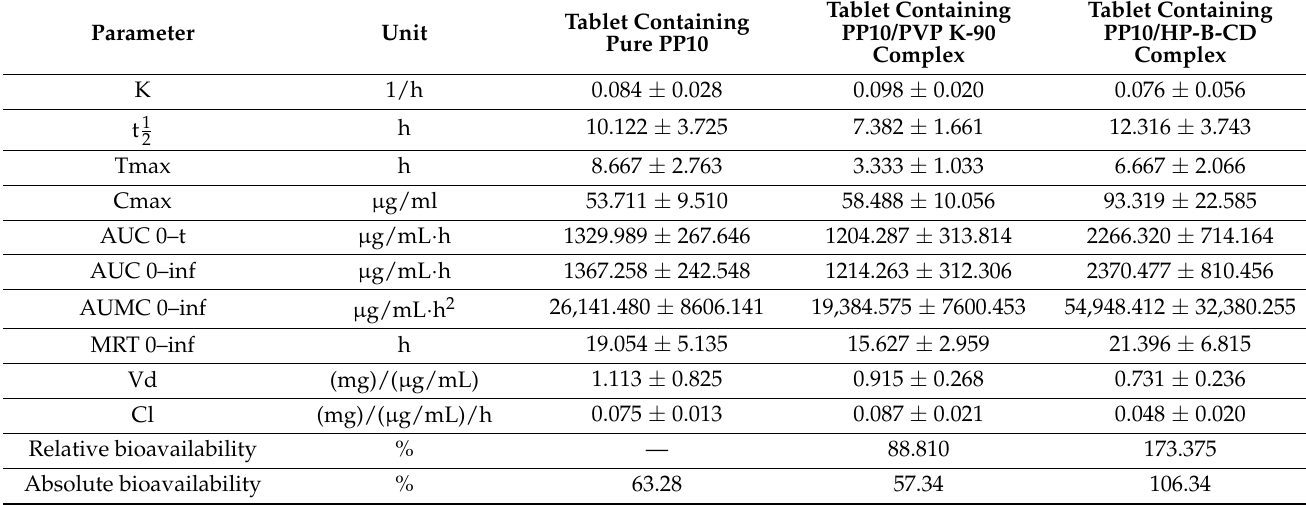
Table 2. Pharmacokinetic parameters of PP10 after oral administration of 100 mg/kg in rats ( n = 6, the data are expressed as mean ±